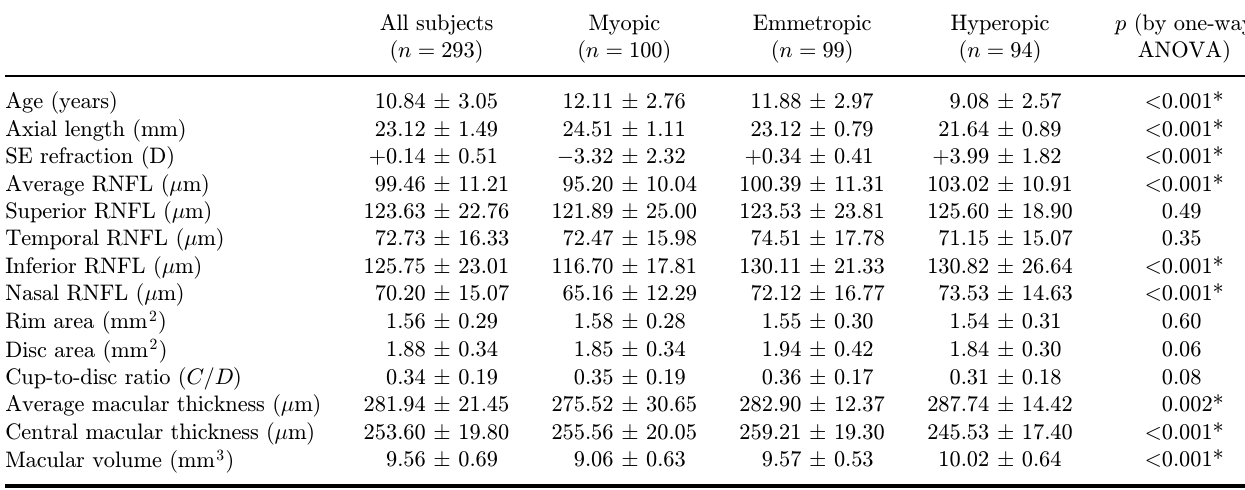
Table 1a. Descriptive and OCT parameters in the entire group and in the three groups examined: emmetropic, myopic and hyperopic